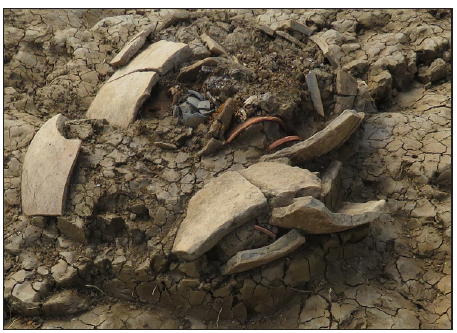
Figure 4: Multiple period excavations near Red Lodge, Suffolk (Photo: ASE).